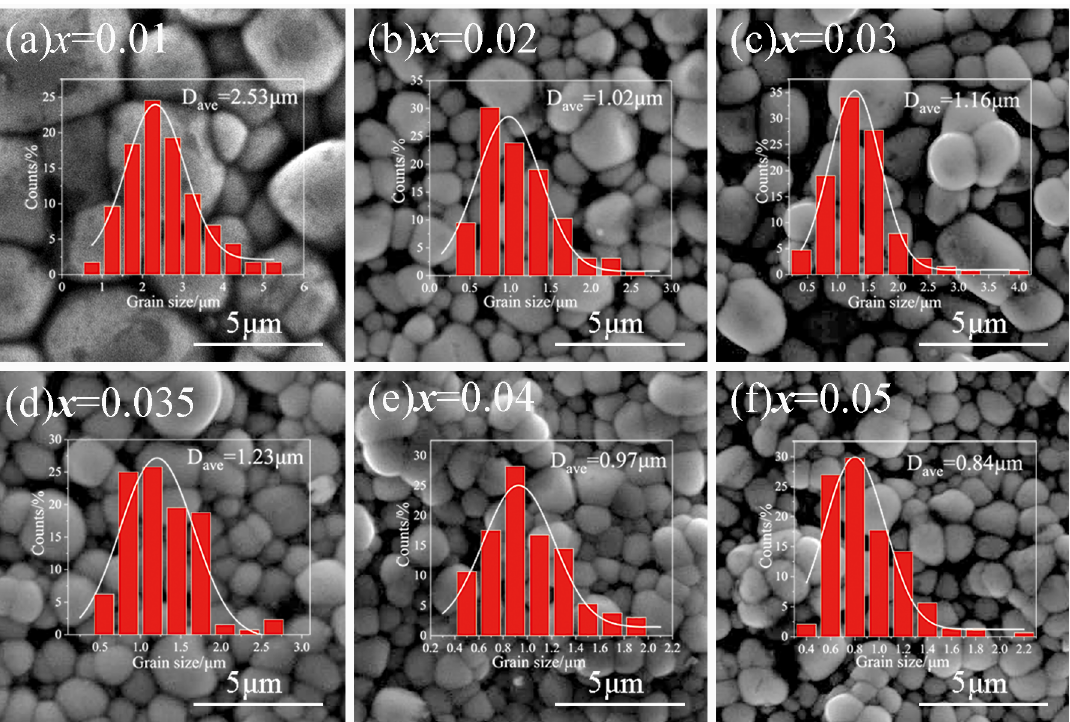
Figure 2. Surface morphologies and grain size distribution of BNBT- x NT